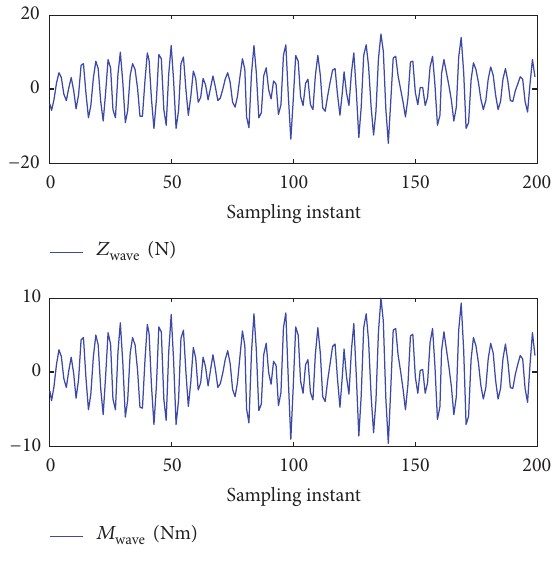
Figure 10: Wave force and